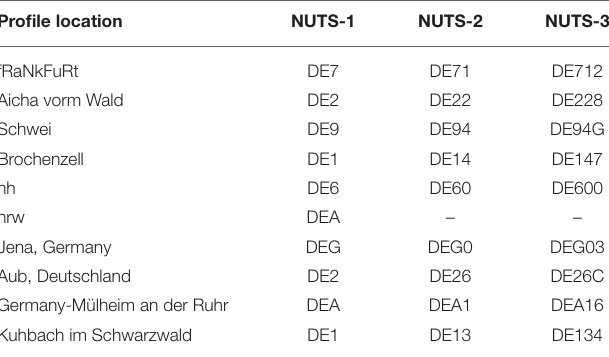
TABLE 2 | Random sample of geocoding results where the input is the Twitter profile location and the output is the corresponding administrative regions in Germany.